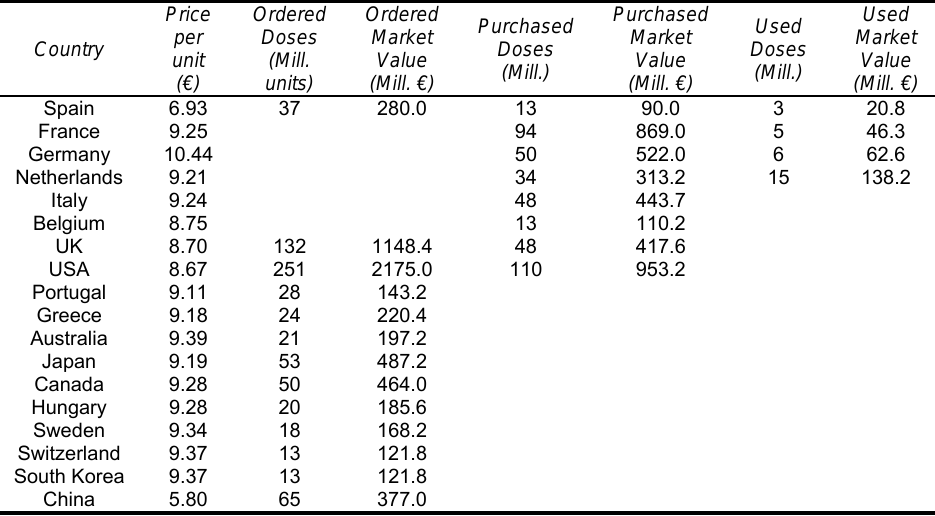
Table 2: Pandemic Influenza H1N1: Vaccine Orders and Purchases (2009-2010) Price Ordered Ordered Purchased Used Purchased Used per Doses Market Market Market Doses Doses Country unit (Mill. Value Value Value (Mill.) (Mill.) (€) units) (Mill. €) (Mill. €) (Mill. €) Spain 6.93 37 280.0 13 90.0 3 20.8 France 9.25 94 869.0 5 46.3 Germany 10.44 50 522.0 6 62.6 Netherlands 9.21 34 313.2 15 138.2 Italy 9.24 48 443.7 Belgium 8.75 13 110.2 UK 132 1148.4 48 8.67 953.2 Portugal 143.2 Greece 220.4 Australia